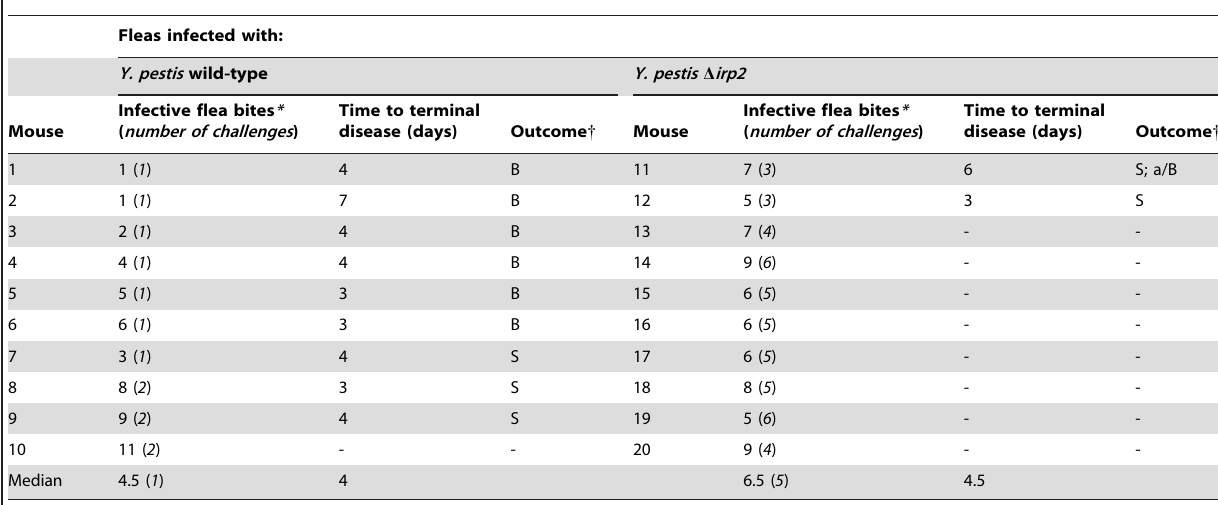
*Cumulative number of bites from blocked fleas. { B and a/B, typical and atypical bubonic plague respectively; S, primary septicemic plague; -, no disease.